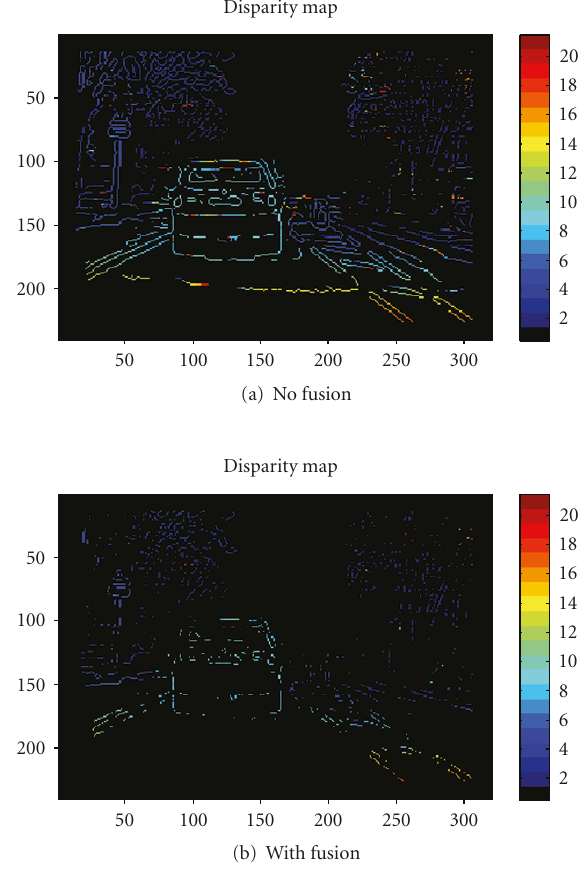
Figure 4: Disparity maps with fusion and no fusion with optic